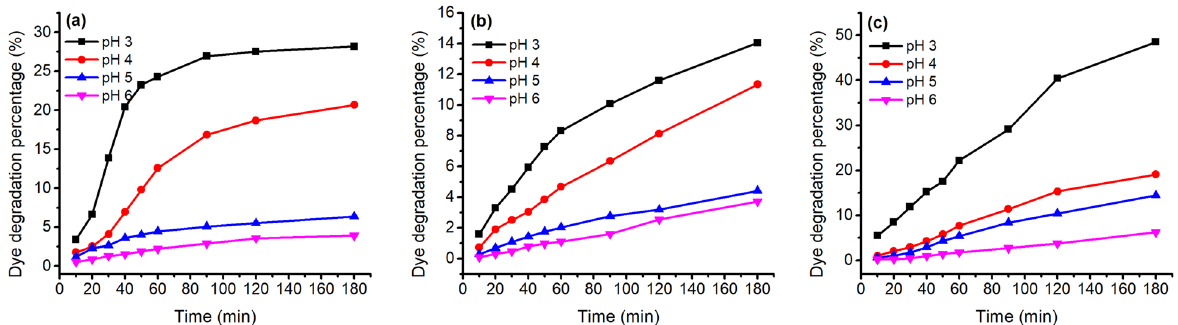
Figure 6. Thermostability of 80 mg L −1 of ( a ) MR, ( b ) GB, and ( c ) GY dyes in deionized water at pH 3–6 and 70